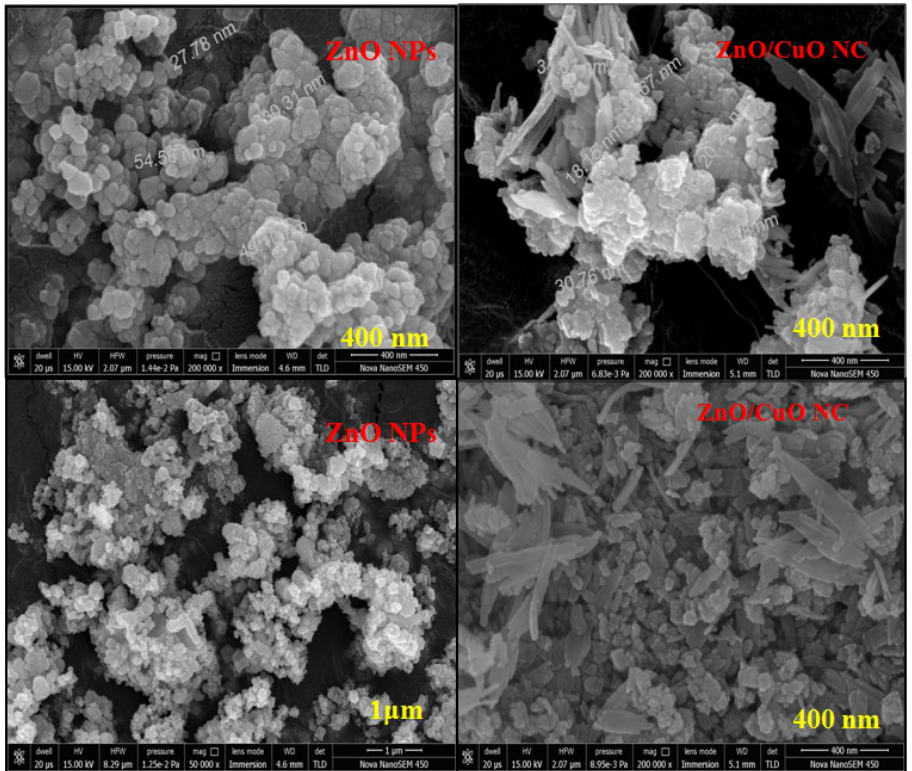
Fig.3. SEM images of prepared samples (a) ZnO (b) ZnO/CuO